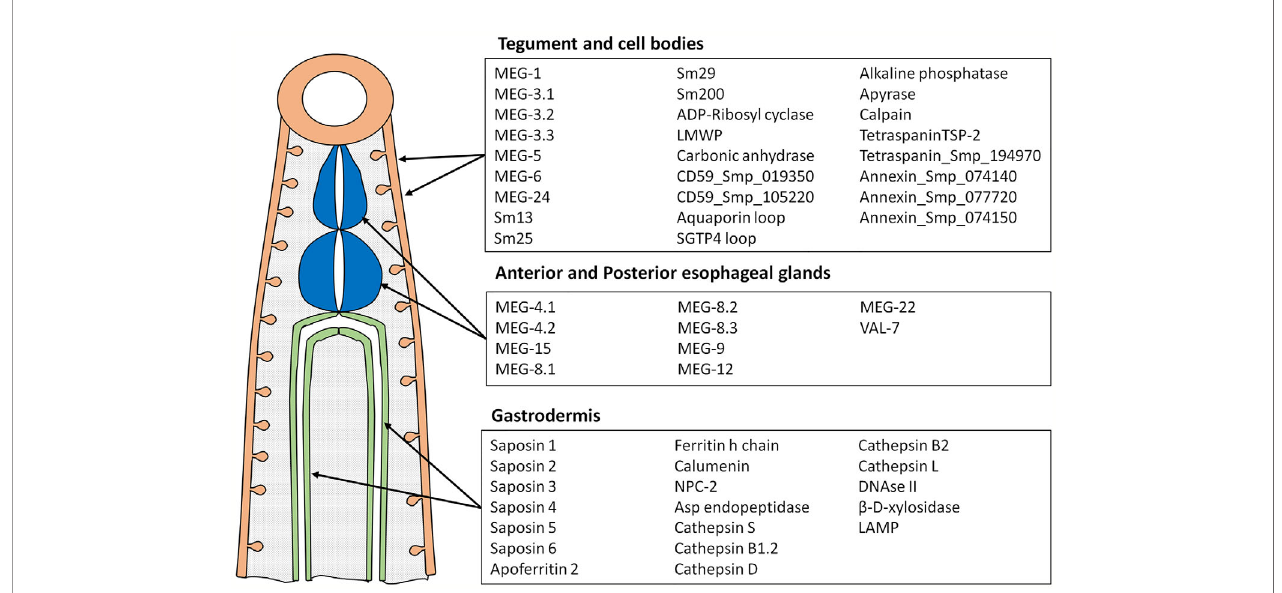
FIGURE 1 | Diagram showing tissues where proteins printed on the array originate and the list of proteins in each category. These tissues represent the major parasite-host interface where antigens are exposed or released into the blood